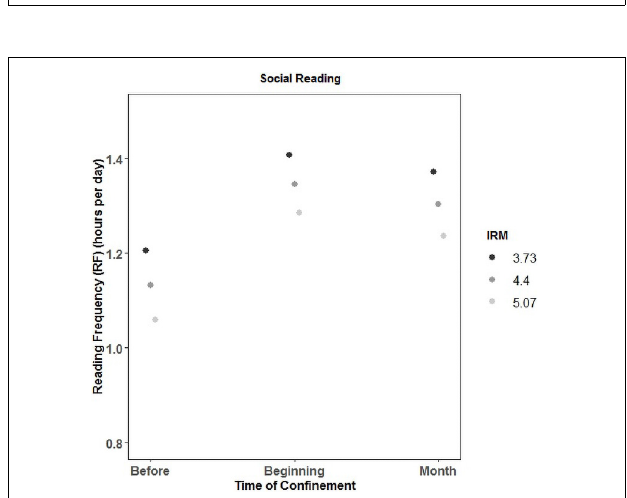
FIGURE 2 | Interaction between reading frequency (RF), time, and intrinsic reading motivation (IRM) for social reading.